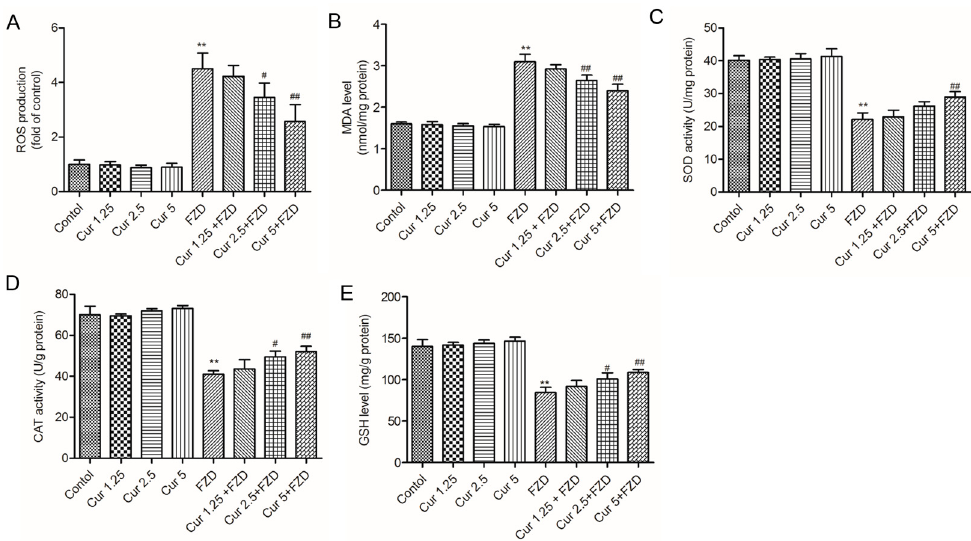
Figure 2. Curcumin protects against FZD induced oxidative stress in L02 cells. ( A ) Intracellular ROS levels were detected using the ROS sensitive dye 2,7-dichlorofluorescein diacetate staining; ( B – E ) The effects of curcumin pretreatment at 1.25, 2.5 and 5 µ M on the cellular MDA level, SOD, CAT activities and GSH level. Values were presented as mean ± SD, from three independent experiments. ** p <0.01, compared to the negative control group; # p < 0.05, ## p < 0.01, compared to the FZD alone group.